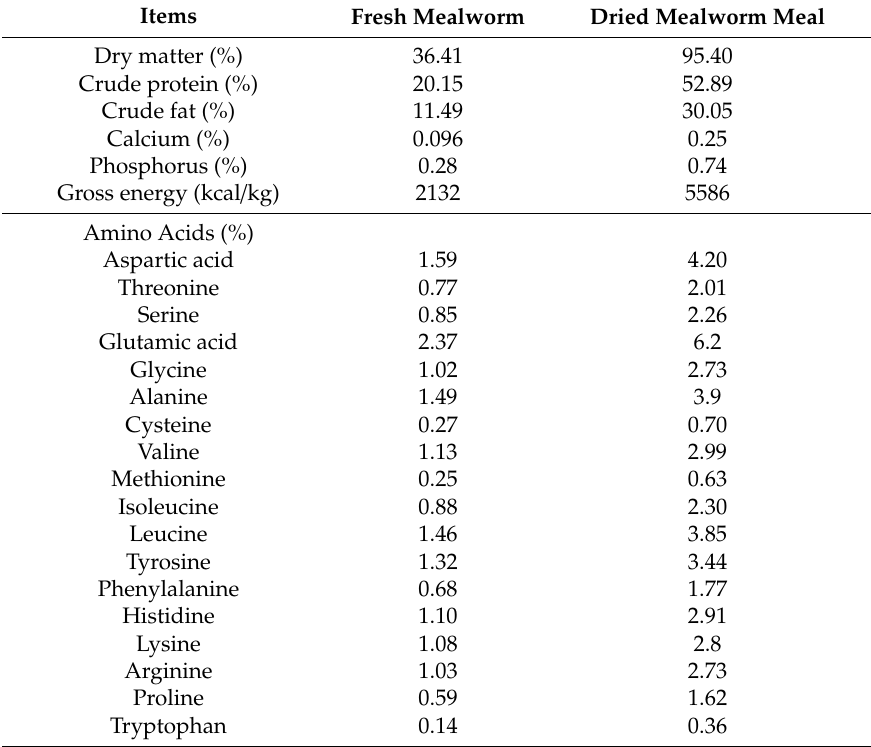
Table 2. Nutrient and amino acids composition of the yellow